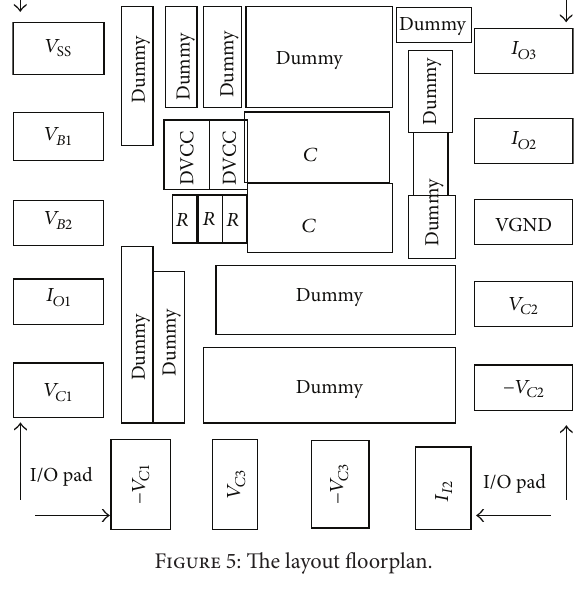
Figure 5: The layout floorplan.